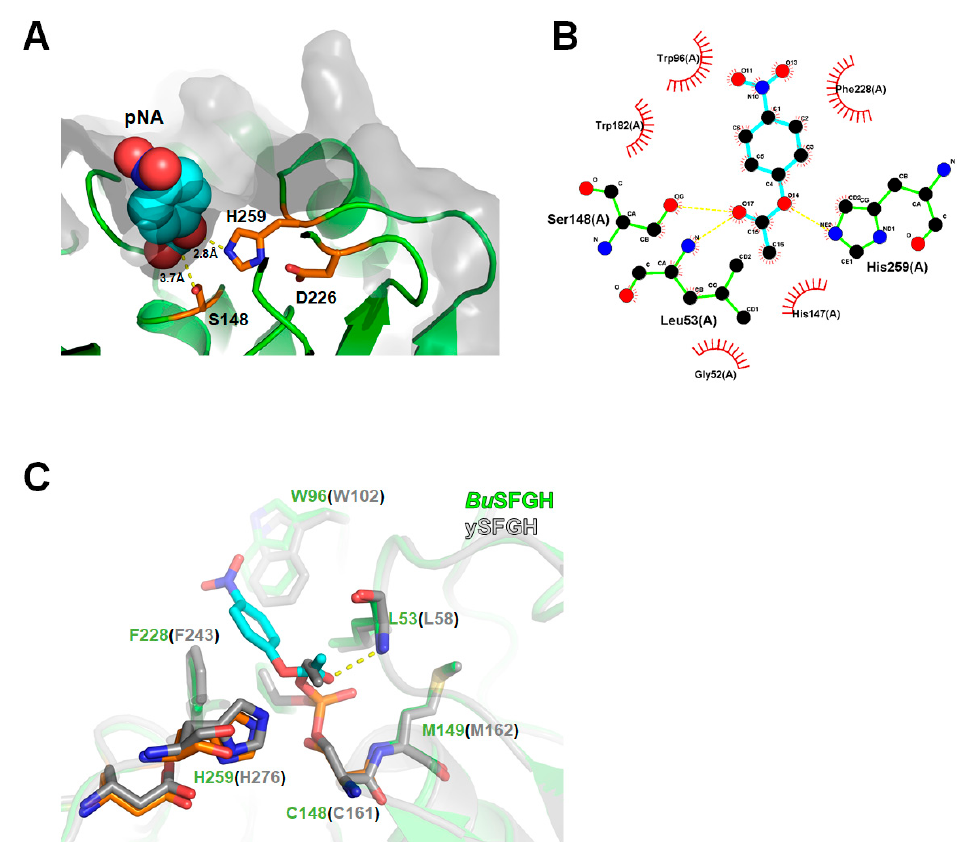
Figure 5. Computational docking model structure of p-NA-bound Burkholderiaceae sp. S-formylglutathione hydrolase ( Bu SFGH). ( A ) The p-NA (space-filling model) binding mode in Bu SFGH. ( B ) The bound p-NA molecule and interacting residues of Bu SFGH are shown as a LigPlot diagram. Hydrogen bonds are represented as green-dashed lines, and hydrophobic interactions are shown as red arcs. ( C ) Superimposed side chain representation of active site residues of Bu SFGH (green) and ySFGH (gray). 2-Amino-3-(Diethoxy-Phosphoryloxy)-Propionic Acid (reaction product of paraoxon) complexed with ySFGH (PDB code: 3C6B) was used for superimposition and is represented with ribbon and stick model. Hydrogen bonding is indicated with yellow-do tt ed lines.